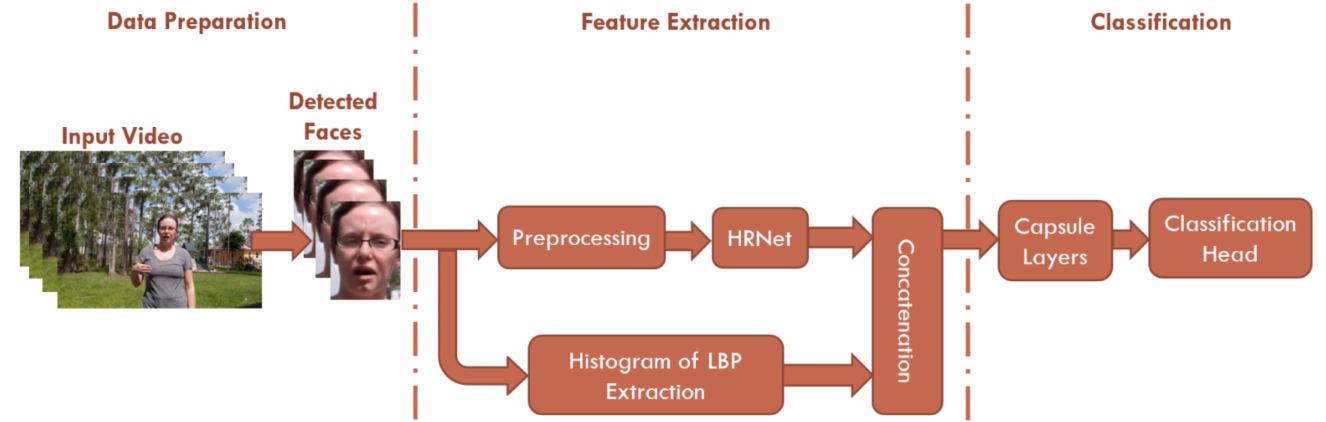
Figure 1. iCaps-Dfake Proposed Model Diagram.